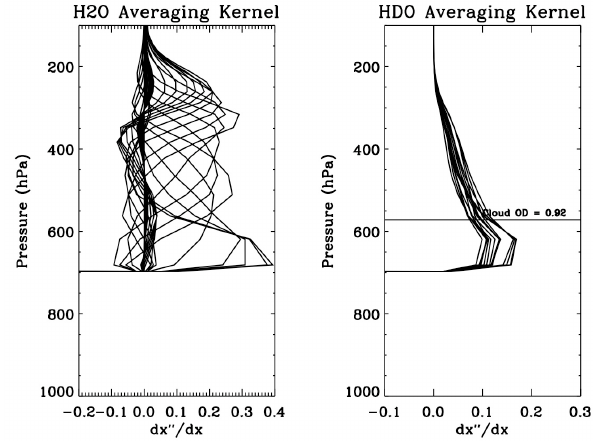
Fig. A5. Error budget for the TES and in situ data comparison for Fig. A3. (Left Panel) Averaging kernels for TES H 2 O profile. 22 October 2008. The diamonds are the pressure levels correspond- Figure A3: (Left Panel) Averaging kernels for TES H 2 O profile. (Right Panel) Averaging (Right Panel) Averaging kernels for TES HDO profile. The cloud ing to in situ measurements. The black line is the total error for the kernels for TES HDO profile. The cloud top height is shown as a solid in the right panel. top height is shown as a solid in the right panel. constructed true profile. The red line is the observation error (noise Figure A5: Error budget for the TES and in situ data comparison for Oct. 22 2008. The + interfering species) for the TES estimate. The green line is the er- diamonds are the pressure levels corresponding to in situ measurements. The black line is ror in the difference between the TES estimate and the true profile the total error for the constructed true profile. The red line is the observation error (noise after accounting for the TES sensitivity. + interfering species) for the TES estimate. The green line is the error in the difference between the TES estimate and the true profile after accounting for the TES sensitivity.